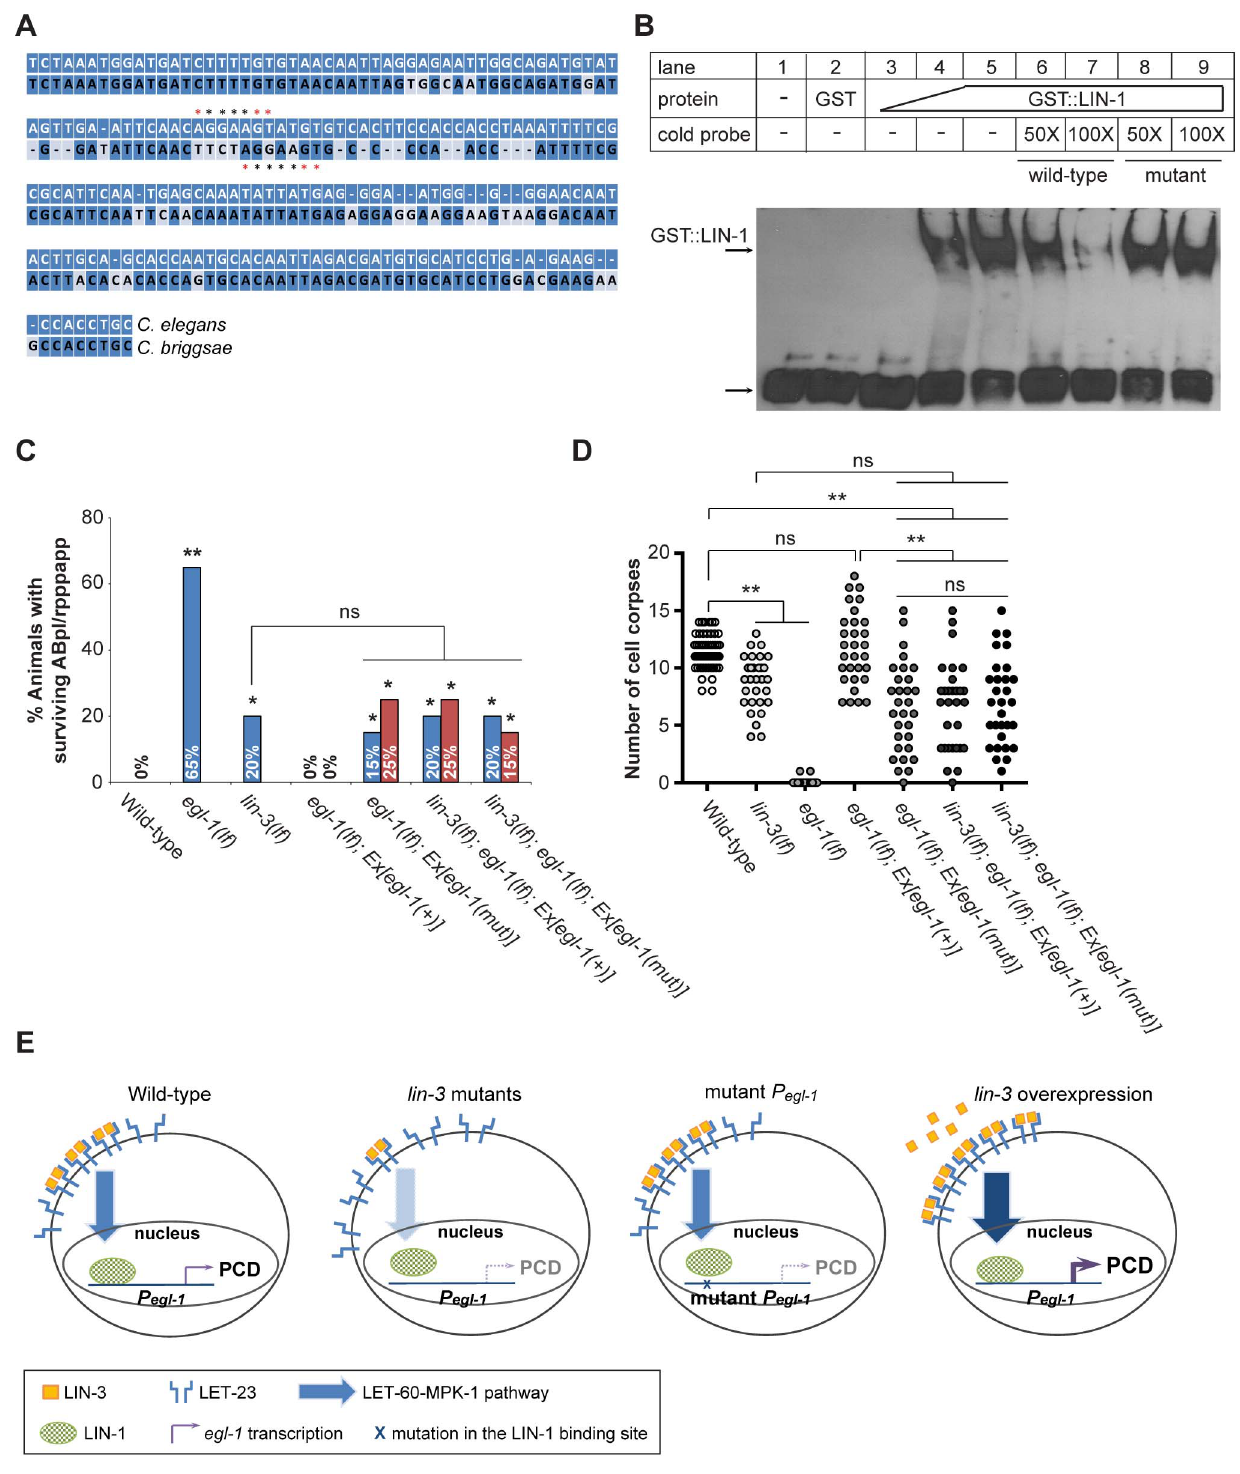
Figure 6. lin-3 promotes PCD through transcriptional activation of egl-1 by LIN-1. (A) The alignment between the C. elegans and C. briggsae genomic sequences near the P3 fragment. *indicates the LIN-1 minimal recognition sequence GGAA/T. (B) GST::LIN-1(DBD) directly binds to the egl-1 promoter in an EMSA assay. Lane 1, no protein; lane 2, 200 ng of GST; lanes 3–5, 10, 50, or 200 ng of GST::LIN-1(DBD); lane 6: 200 ng of GST::LIN- 1(DBD) + 50 6 wild-type cold probe; lane 7, 200 ng of GST::LIN-1(DBD) + 100 6 wild-type cold probe; lane 8, 200 ng of GST::LIN-1(DBD) + 50 6 mutant cold probe; lane 9, 200 ng of GST::LIN-1(DBD) + 100 6 mutant cold probe. The bottom arrow indicates non bound probe and the top arrow DNA bound to GST::LIN-1(DBD) and displaying retarded mobility. (C) The percentage of animals with surviving ABpl/rpppapp of the indicated genotypes was scored (n $ 30). Ex[egl-1( + )] and Ex[egl-1(mut)] indicate wild-type and mutant egl-1 transgenes, respectively, as described in the text. The surviving ABpl/ rpppapp was scored using the sur-5::gfp reporter as described in Figure 1B. Two independent stably transmitted lines were analyzed for each transgene. Alleles used: lin-3(e1417) and egl-1(n1084n3082) . *indicates P , 0.05 and ** P , 0.001 when egl-1(lf) and lin-3(lf) were compared to wild-type